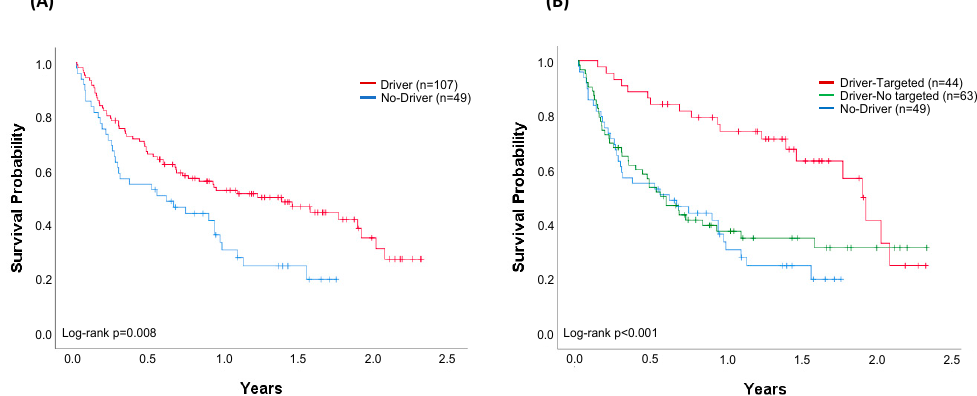
Figure 4. Overall survival (OS). ( A ) Entire cohort of successfully genotyped patients diagnosed with metastatic disease through April 2019 ( n = 156). Median OS (95% CI): 0.93 years (0.63–1.24); ( B ) Patients harbouring EGFR ( n = 35) or KRAS ( n = 41) oncogenic driver mutations. For KRAS -mutated patients, 54% received chemotherapy, 12% immunotherapy, and 34% best supportive care. For EGFR -mutated patients, 77% received a matched therapy, 6% chemotherapy, and 17% best supportive care. Median OS (95%CI): EGFR 2.02 years (1.86–2.19); KRAS 0.55 years (0.36–0.74), log-rank p = 0.001. Vertical tick marks are censoring events.